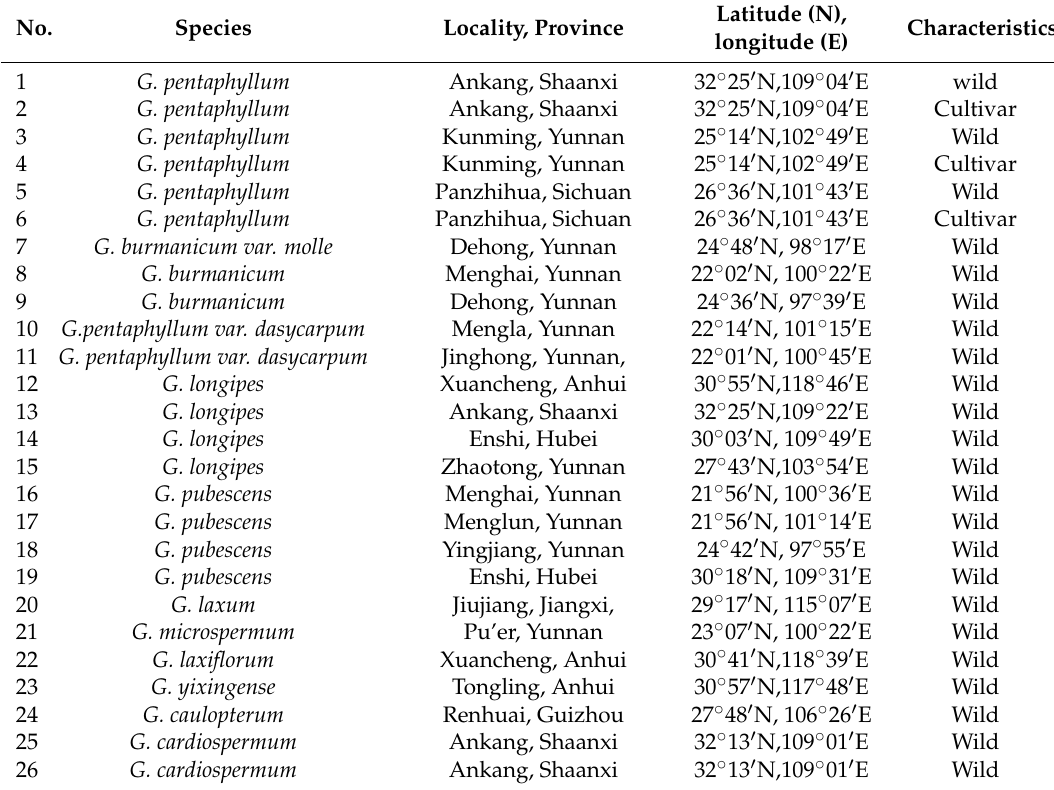
Table 6. The 26 individual plants (belonging to 12 species) used for validation and the genetic diversity